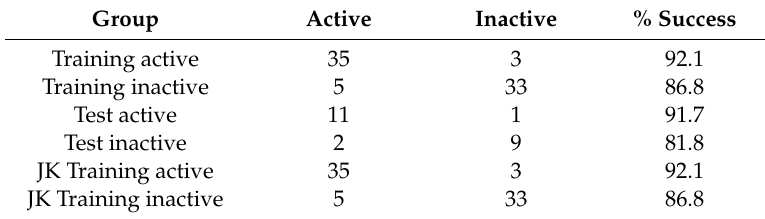
Table 1. Classification matrix for DF1.